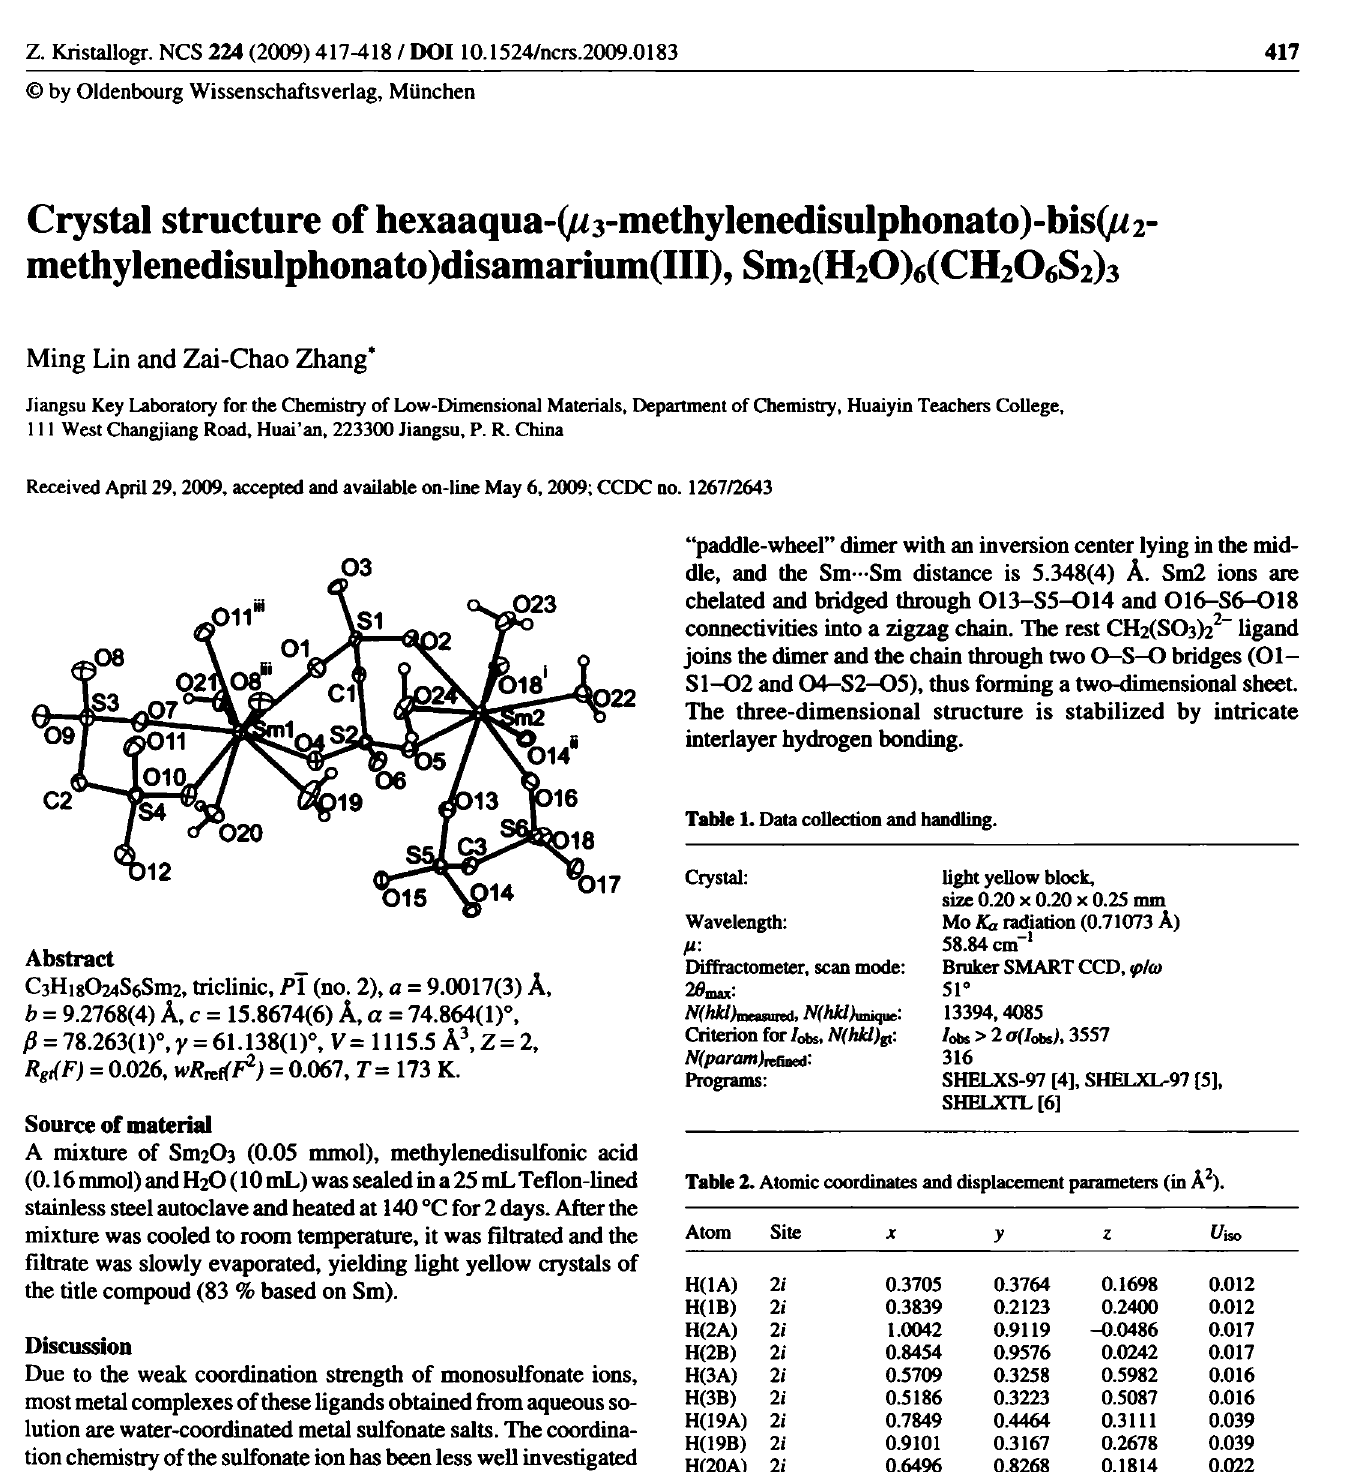
Table 2. Atomic coordinates and displacement parameters (in Â 2